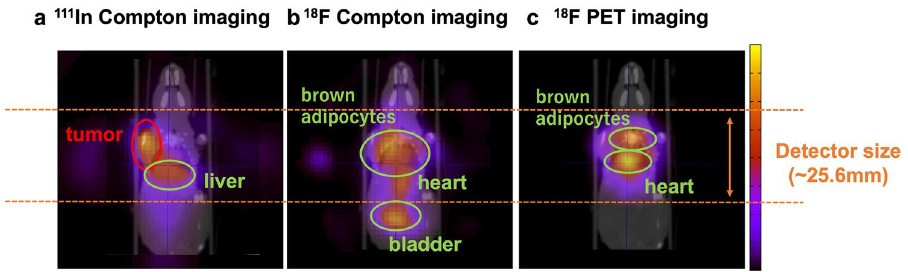
Figure 6. Simultaneous 111 In and 18 F in vivo imaging results. ( a ) A reconstructed image of the 111 In antibody obtained by Compton imaging. The CT image and the reconstructed image are superimposed. The location of the tumor and the liver are visualized. ( b ) A reconstructed image of 18 F-FDG obtained by Compton imaging. The location of the bladder is strongly visualized. ( c ) A reconstructed image of 18 F-FDG obtained by PET imaging. The accumulation in the field of view (FOV), which is determined by the detector size, is